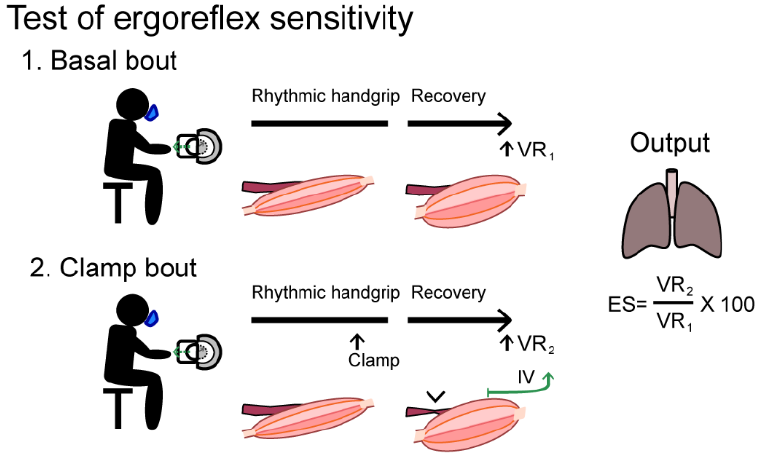
Figure 5. A handgrip test protocol to asses ergoreflex sensitivity.